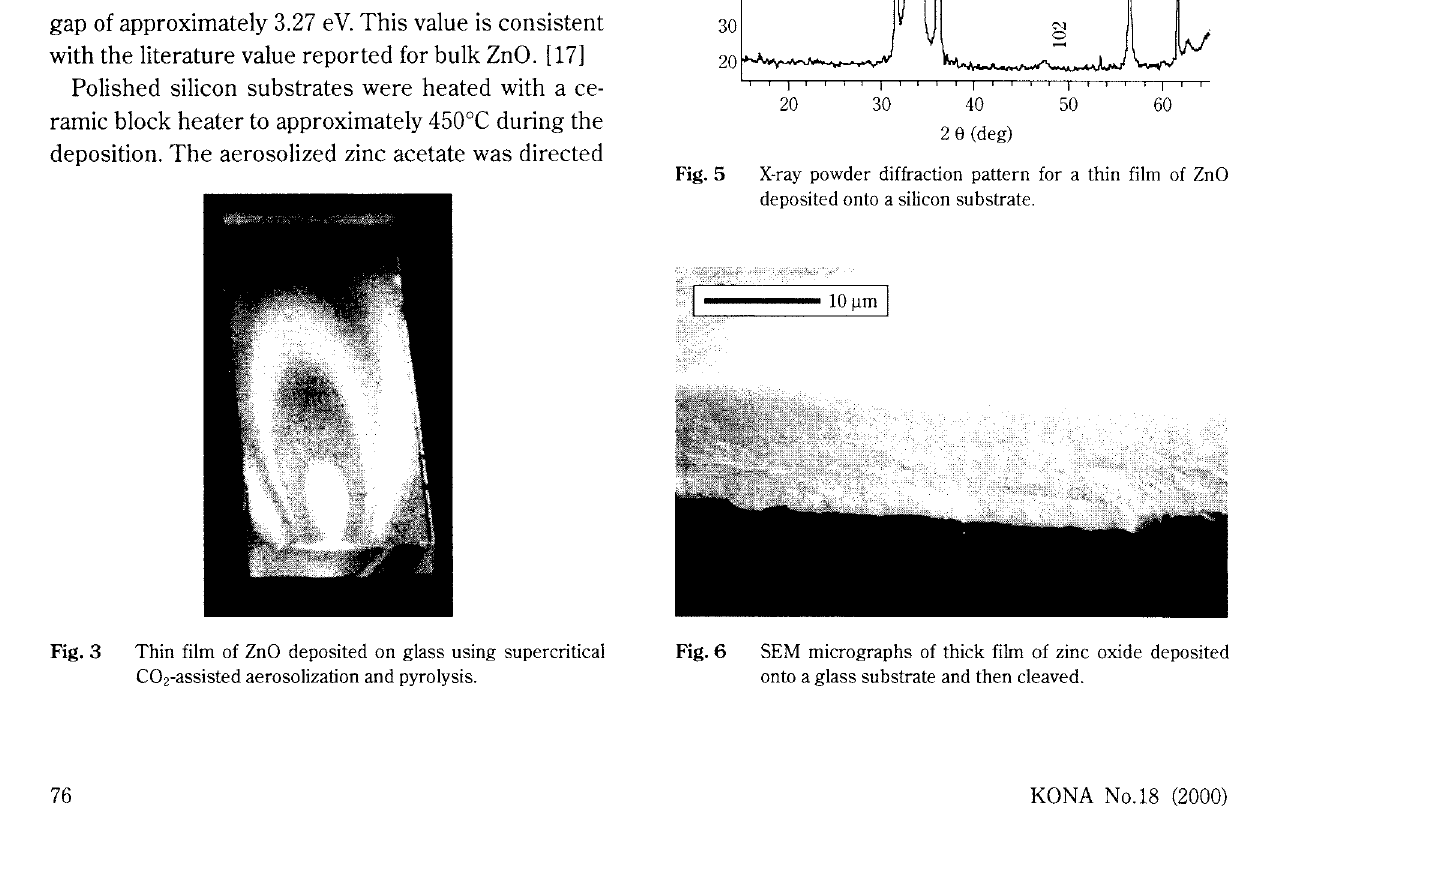
Optical spectrum for thin film of ZnO deposited onto soda lime glass substrate.